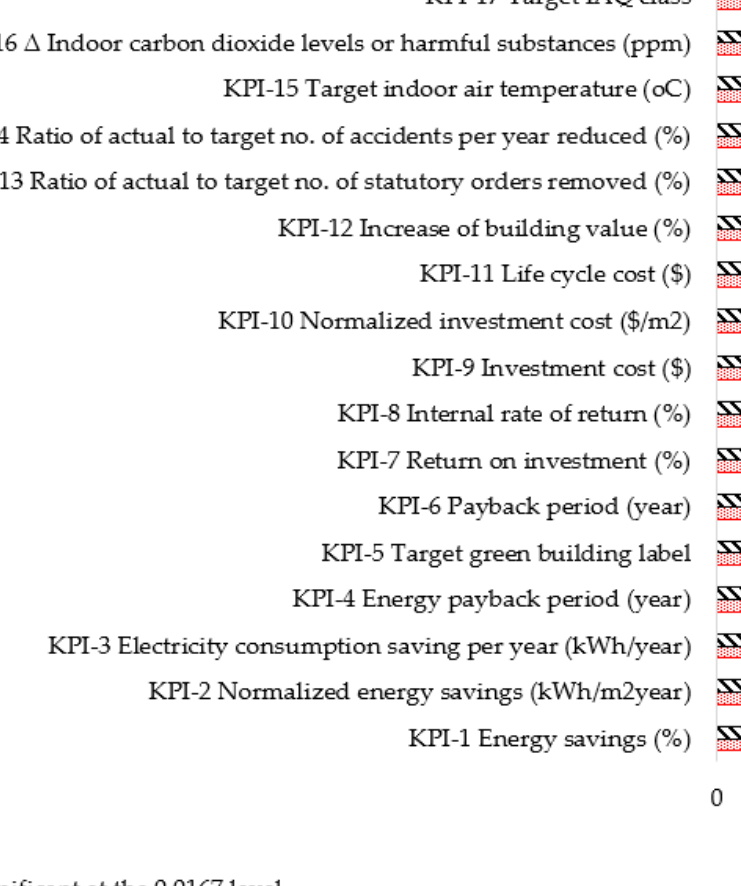
Figure A6. Mann – Whitney U-test results of G2 (work experience: G2a vs. G2c). Figure A6. Mann–Whitney U-test results of G2 (work experience: G2a vs.